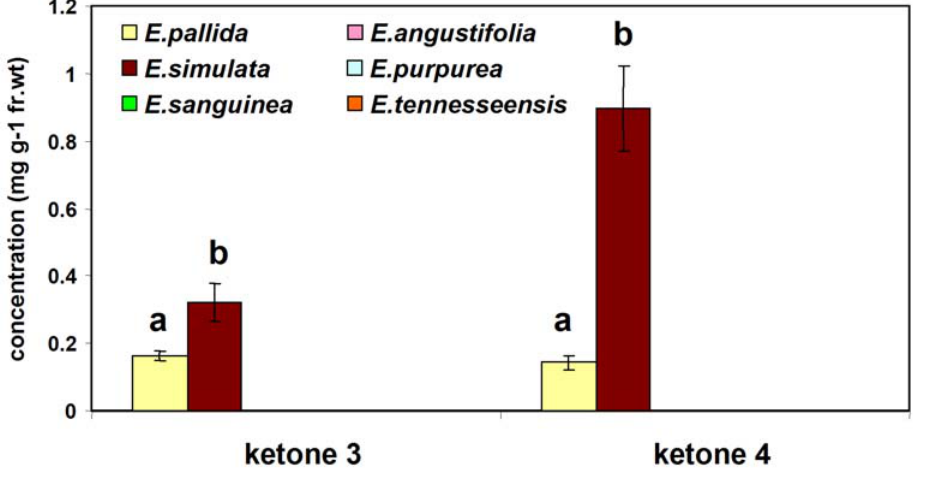
Figure 2. Concentrations of ketones 3 and 4 in two-year-old roots from six species of Echinacea . Error bars indicate standard deviations of means of triplicate experiments. For each ketone, different letters indicate a significant difference ( p <